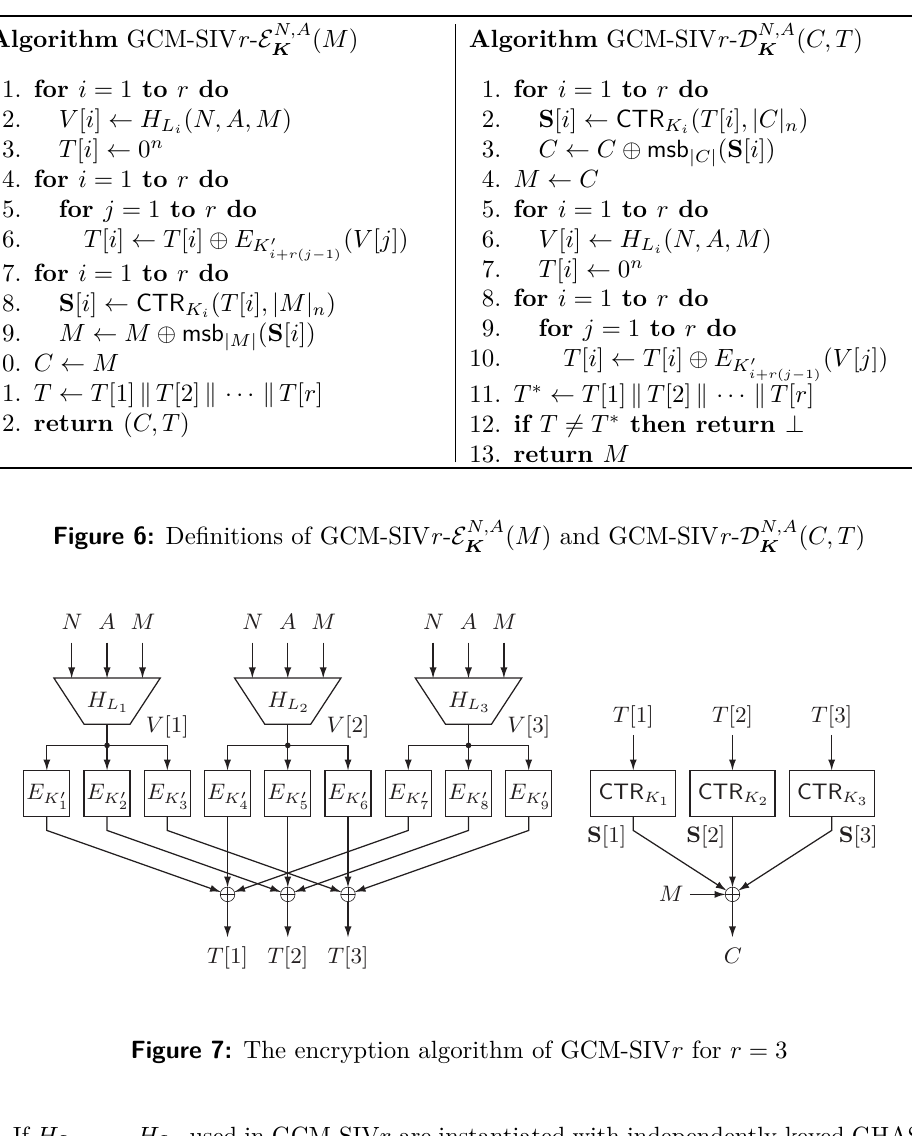
Algorithm GCM-SIV r - E N,A